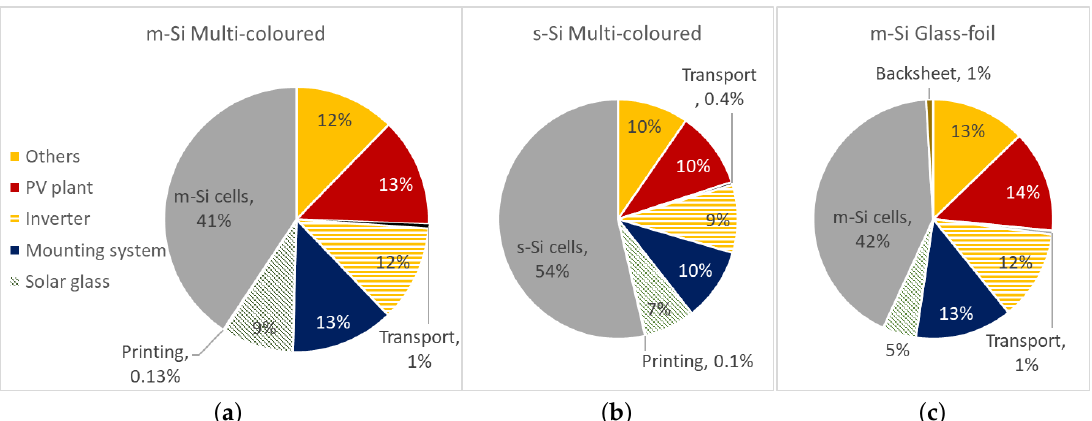
Figure 8. Percentile breakdown of eco-points for various façade configurations consisting of 140 PV modules: 24.6 kWp m-Si ( a ) and 28 kWp s-Si ( b ) multi-coloured glass-glass, and 30.8 kWp traditional foil-glass ( c